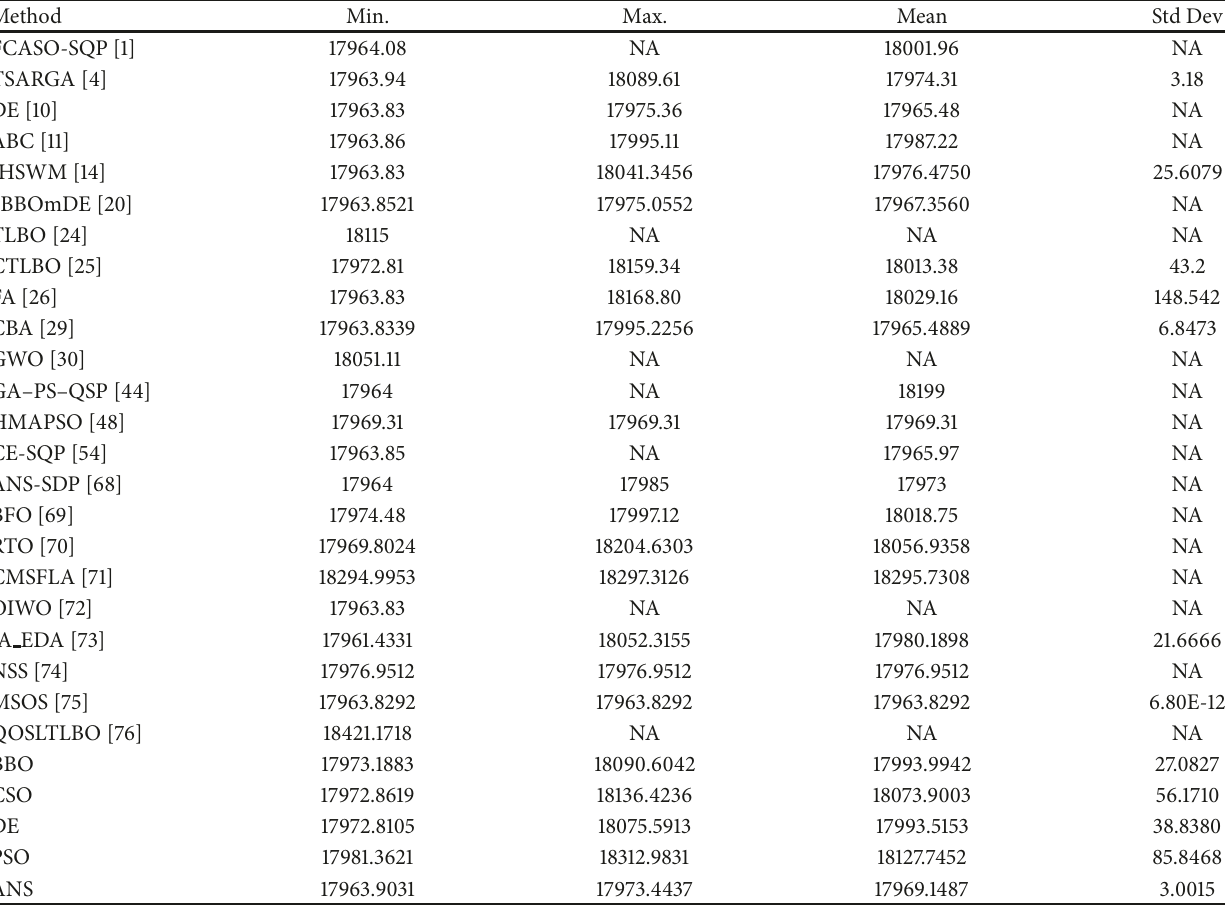
Table 2: Comparison of simulation results ($/h) for 13-generator system (Case III).